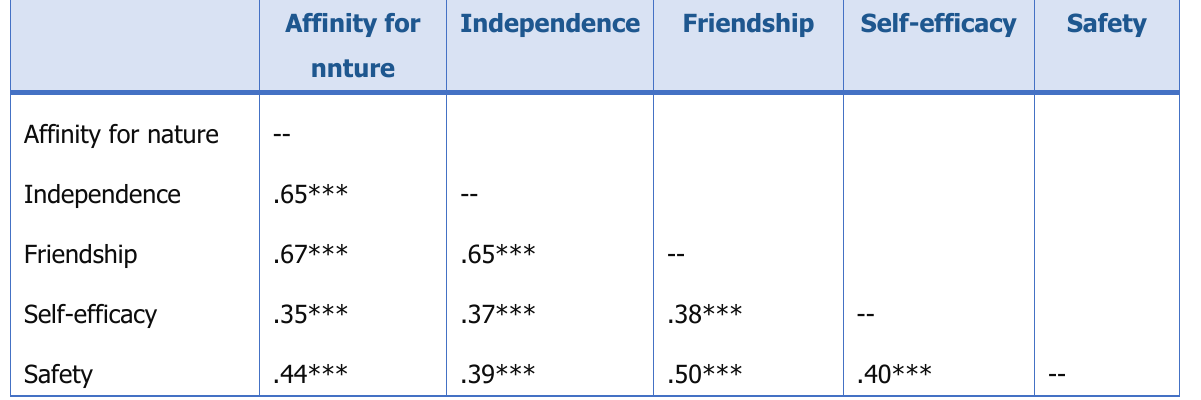
Table 5. Correlations among Outcomes from Summer